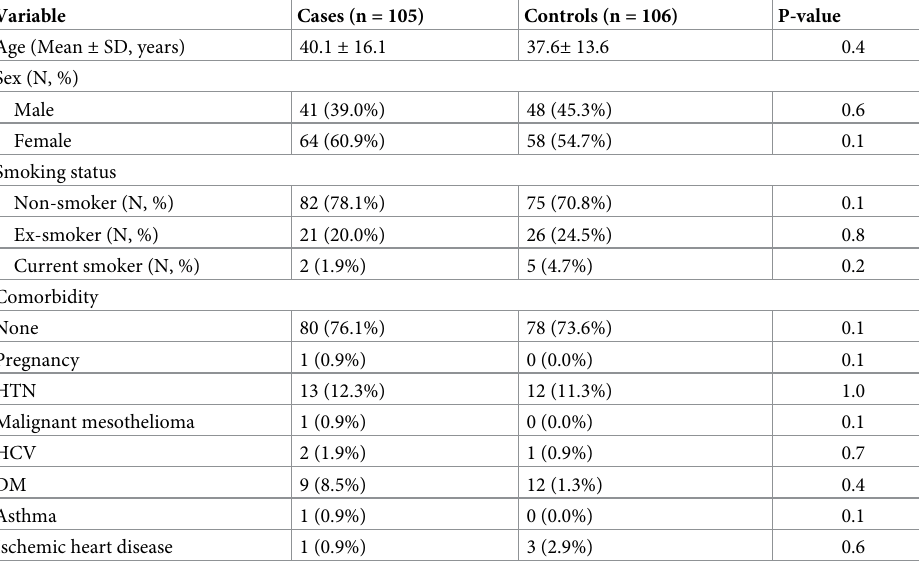
Table 1. Demographic and clinical characteristics of the study participants.